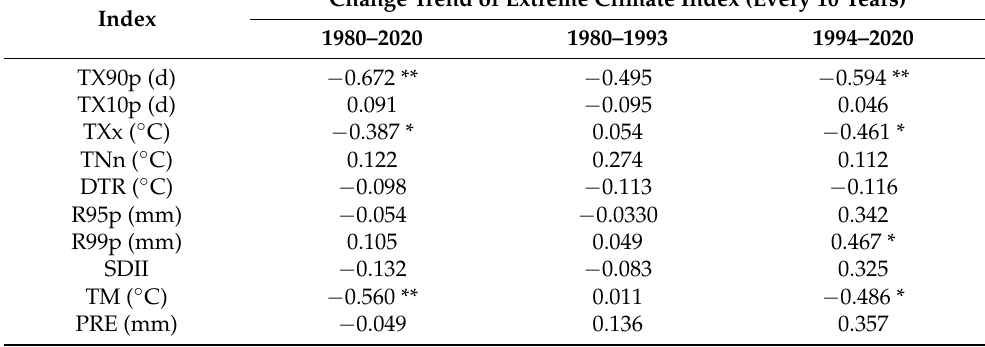
Table 3. Correlation between annual mass balance and regional mean extreme climate indices of